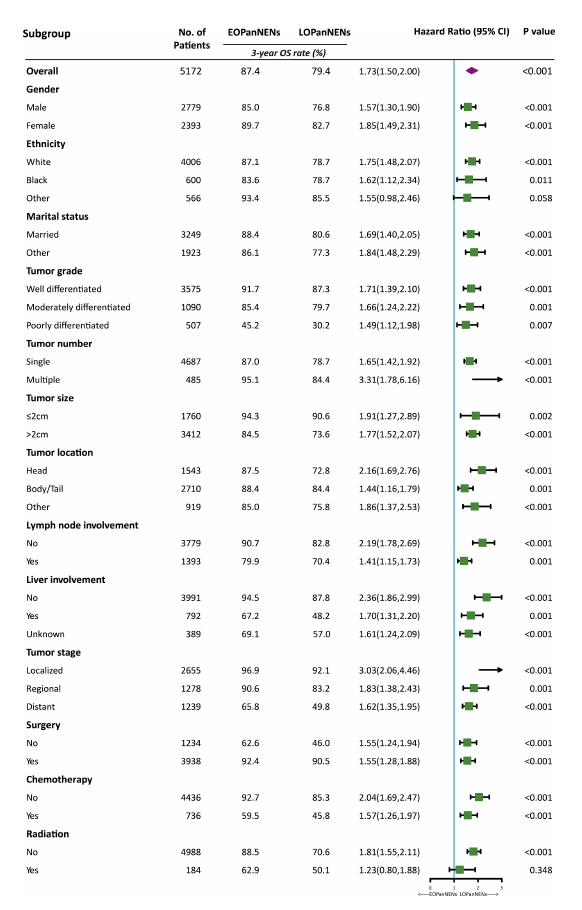
FIGURE 7 3-year overall survival of EOPanNENs compared with LOPanNENs in subgroups of patients with different tumor characteristics and treatment